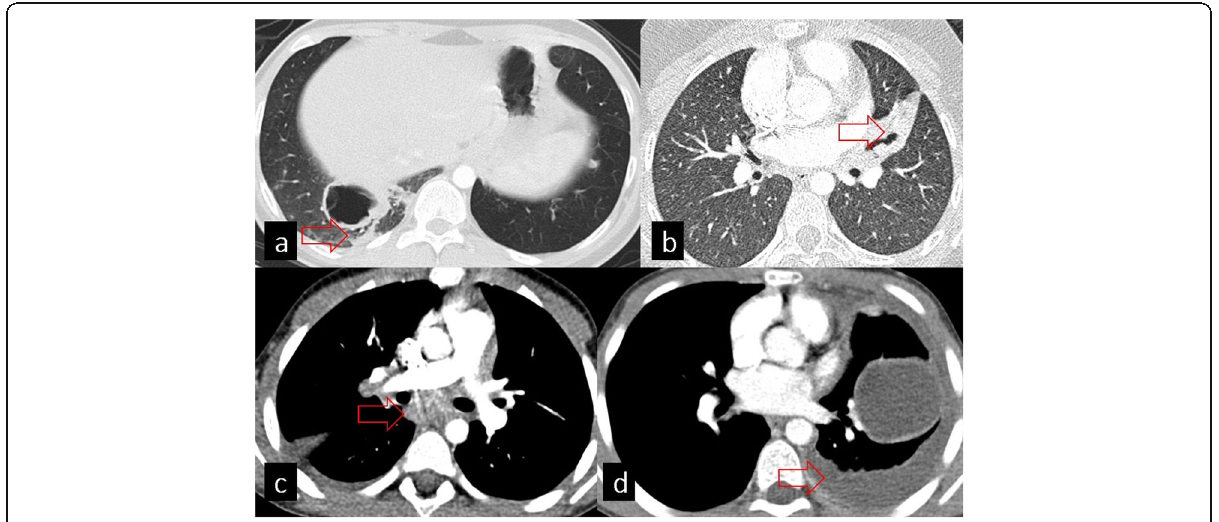
Fig. 8 Axial CT images in the lung ( a , b ) and mediastinal ( c , d ) windows show associated findings of HC. a Atelectasis. b Bronchiectasis. c Mediastinal lymphadenopathy seen especially in hydatic cyst with superinfection. d Pleural